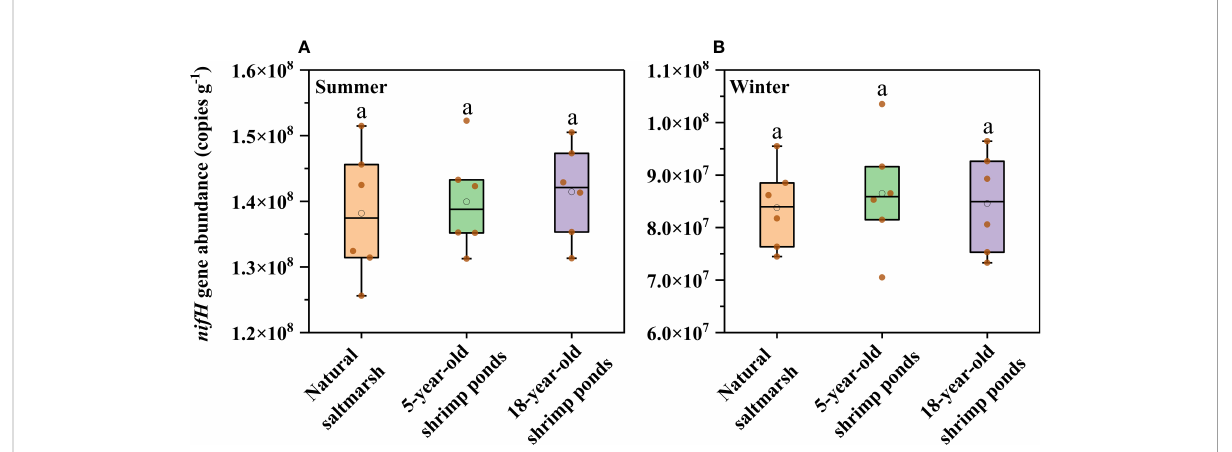
(Table 1). For bulked two-season data, the N fi xation rate was signi fi cantly associated with sediment EC, NH 4+ , NO x − and nifH gene (Table 1). In addition, results from the RDA of sediment physicochemical parameters, nifH gene abundance and N fi xation rate showed that sediment samples in natural saltmarsh were clearly separated from those in shrimp ponds along Axis 1 (Figure 5). The sum of Axis 1 and Axis 2 accounted for 60.4% and 55.3% of the variation in sediment parameters measured in summer and winter, respectively (Figure 5). Sediment N fi xation rate, EC, TOC, NH 4+ , NO 3 – and Fe 2+ /Fe 3+ contributed signi fi cantly to the variation of Axis 1, while nifH gene abundance was minor importance in the variation of Axis 1 (Figure 5). Predicted path model further showed that reclamation time can in fl uence N fi xation rate by affecting sediment EC, NH 4+ and nifH gene abundance (Figure 6). TABLE 1 Pearson ’ s correlation coef fi cients for relations between sediment parameters and N fi xation rates.